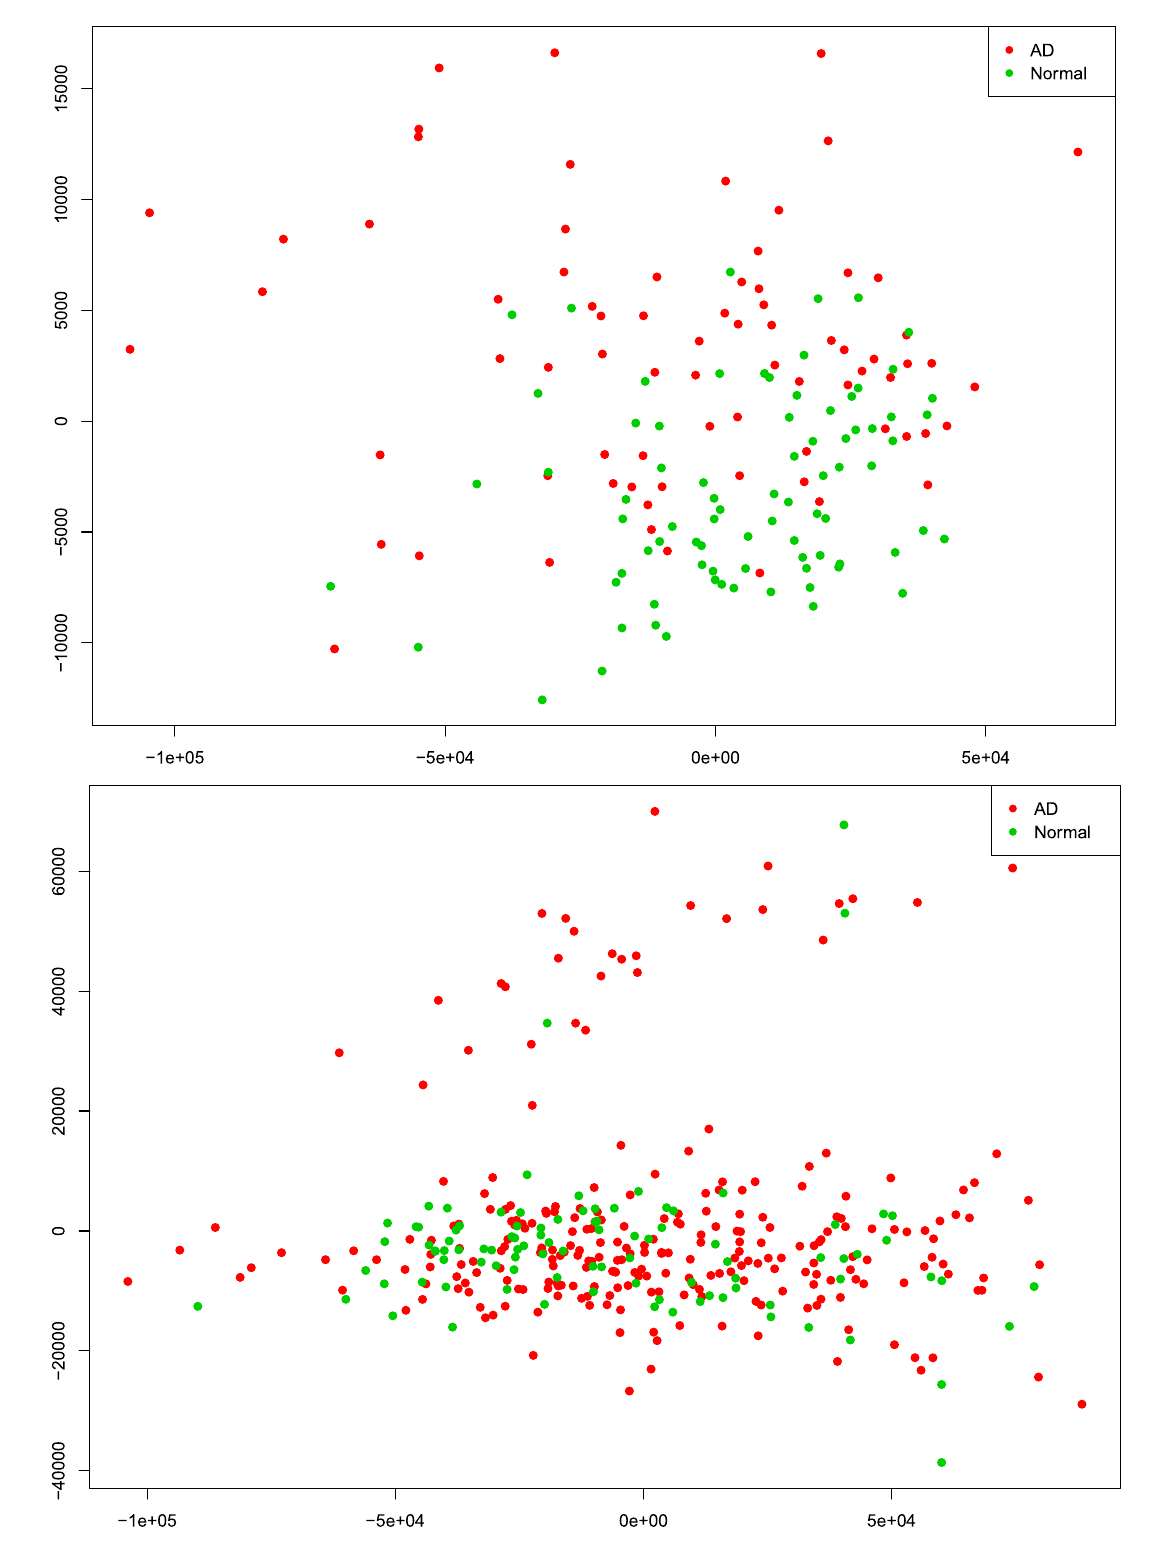
FIGURE1 Alzheimer’s disease (AD) and control tissue samples are not well separable in the first ( x -axis) and second ( y -axis) principal components of MDS analysis on the RNA-seq protein-coding genes in Mayo (top-panel) and ROSMAP (bottom-panel)